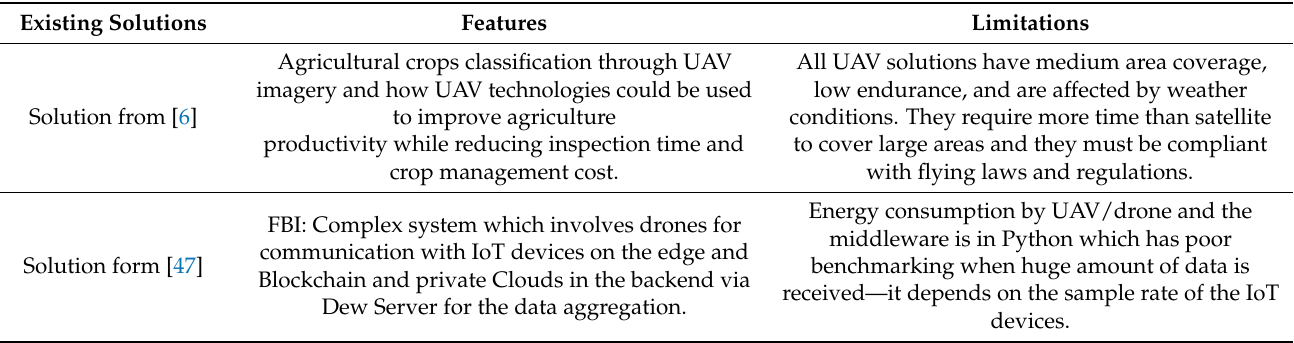
Table 1. Comparison of the several different existing solutions in terms of features and limitations. Existing Solutions